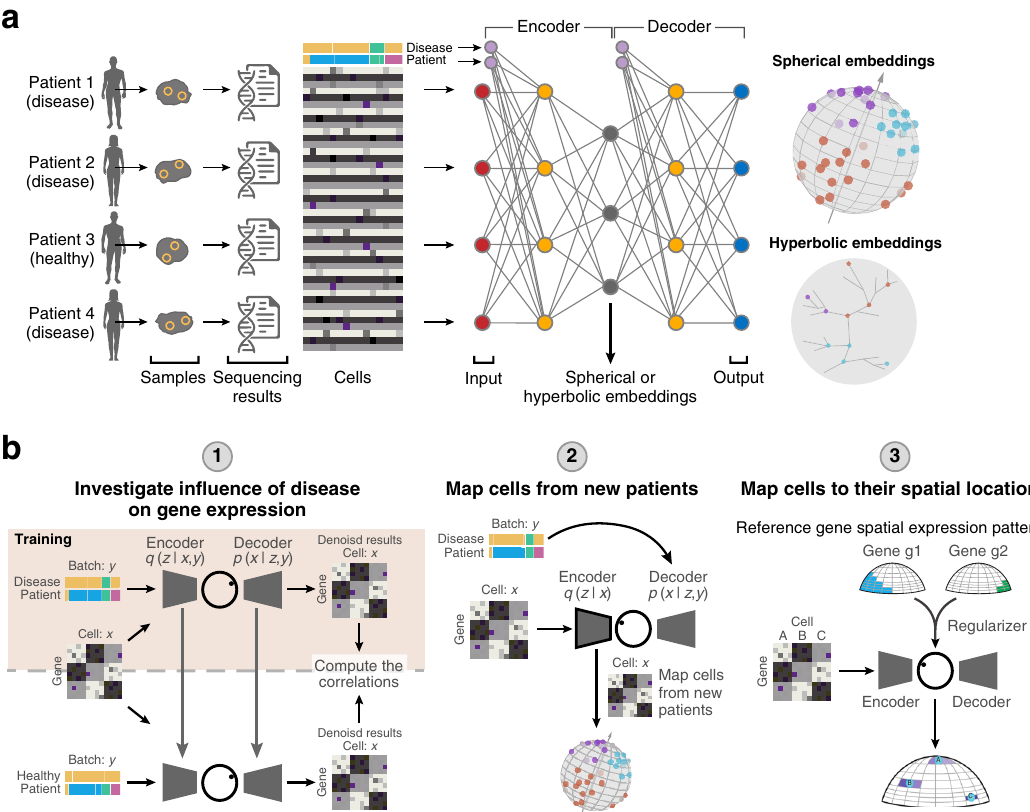
Fig. 1 ScPhere model. a , b Method overview. a ScPhere takes as input scRNA-seq measurements and multilevel technical or biological batch effects (e.g., replicate patient, disease) and learns cells ’ latent structure accounting for the batch effects. b The learned scPhere model and the low-dimensional latent representations of cells are used for diverse queries, including (1) identifying the in fl uence of a biological factor on expression, (2) generating a batch- invariant reference and mapping new datasets to the reference, and (3) mapping cells to their spatial